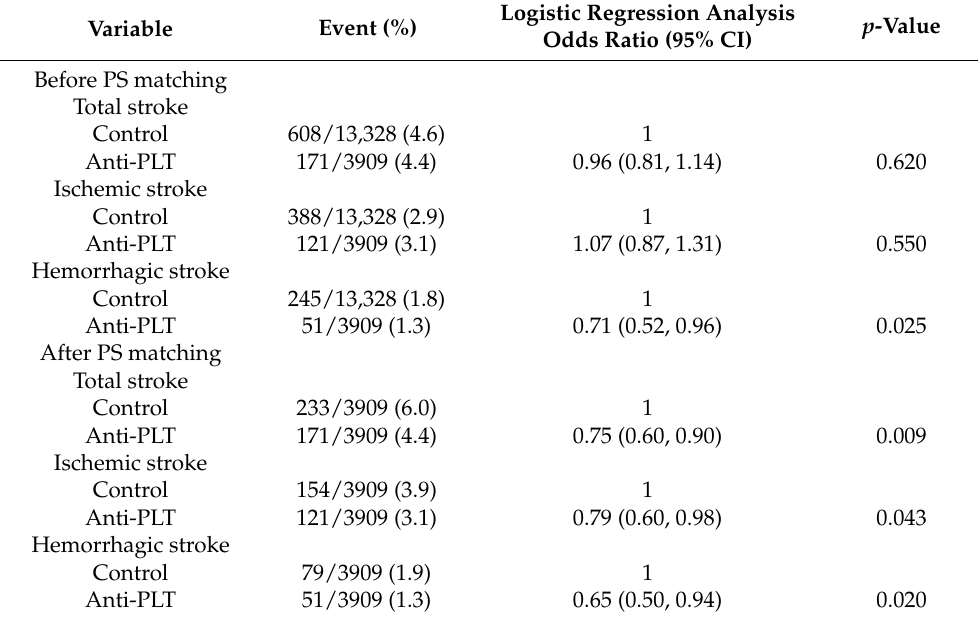
Table 5. Stroke incidence before and after PS